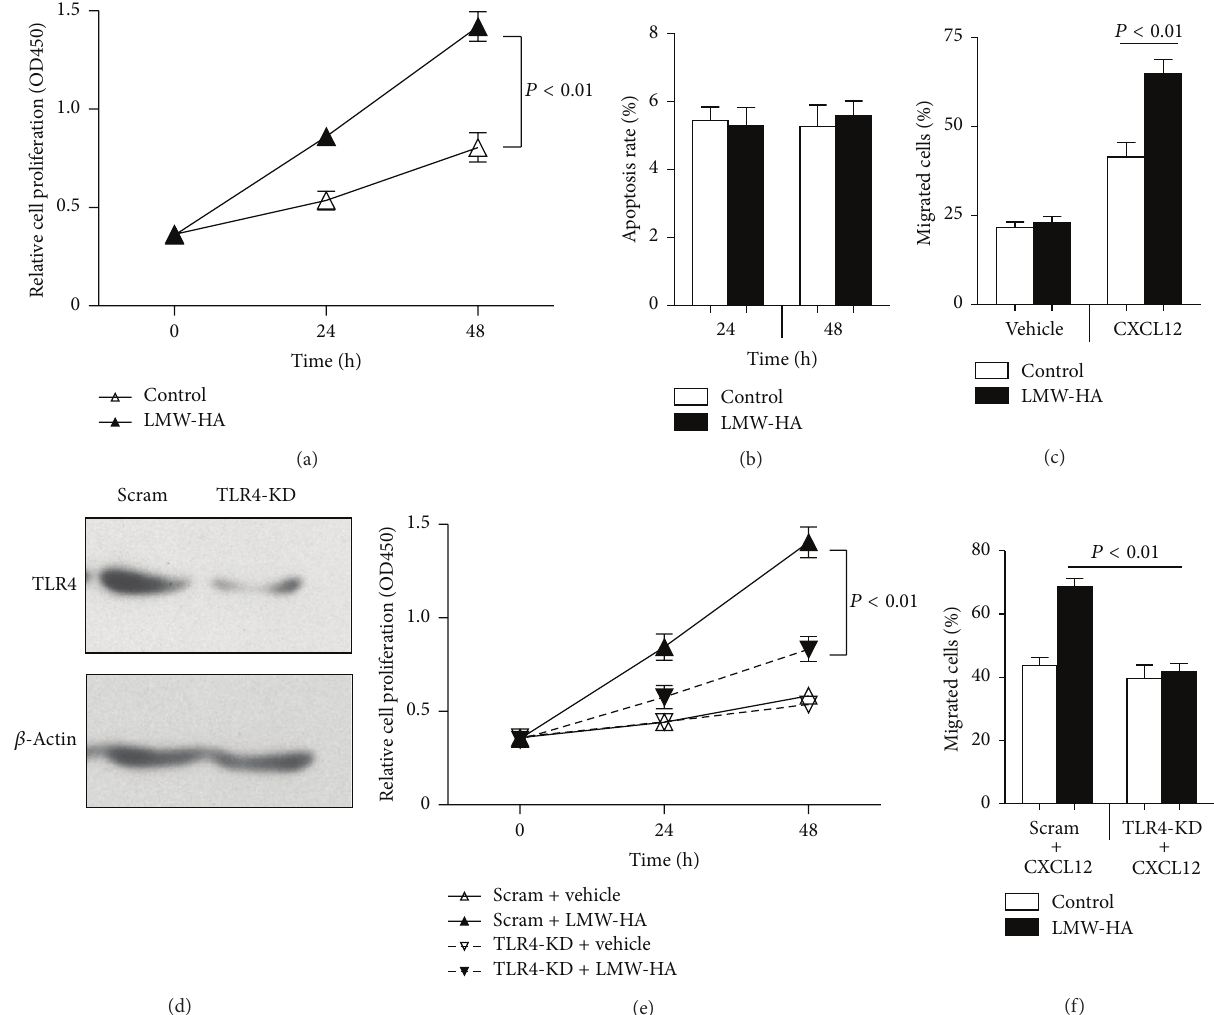
Figure2:LMW-HApromotesW3cellproliferationandmigrationviaTLR4.(a)W3cellswereseededinto96-wellplates(2,000